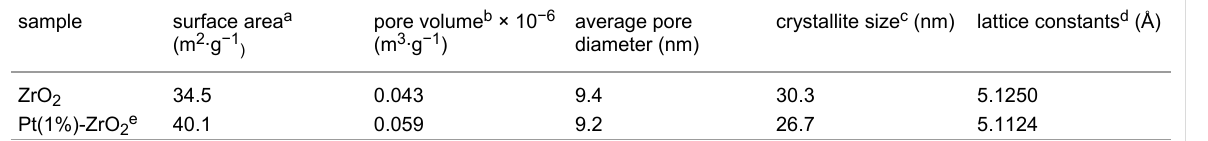
Table 1: Sample characterization by BET and